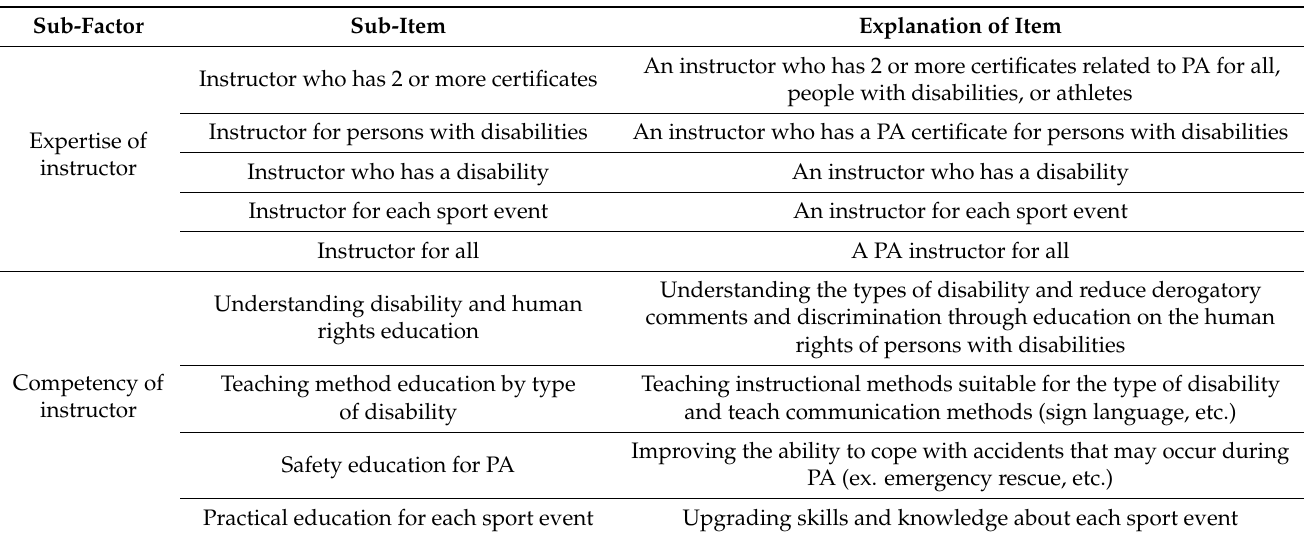
Table 10. Explanation of H4 by the instructor in